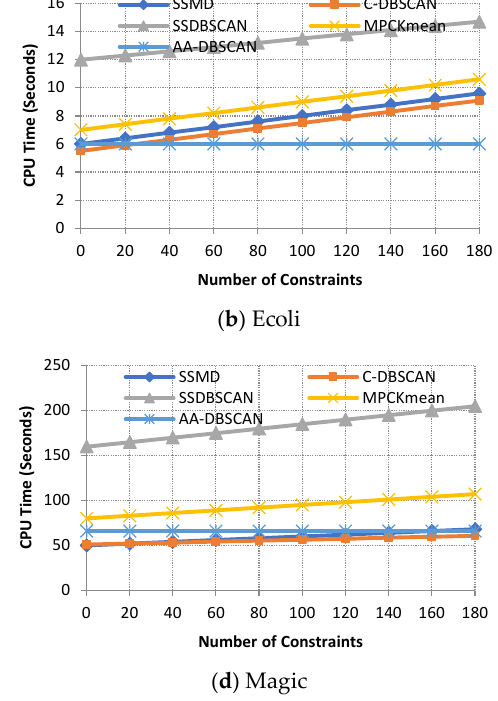
Figure 3. Comparison of the execution time.